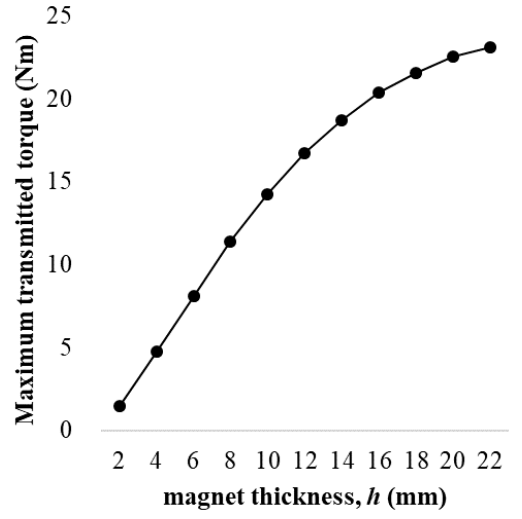
Figure 10. The maximum transmitted torque versus the magnet thickness.